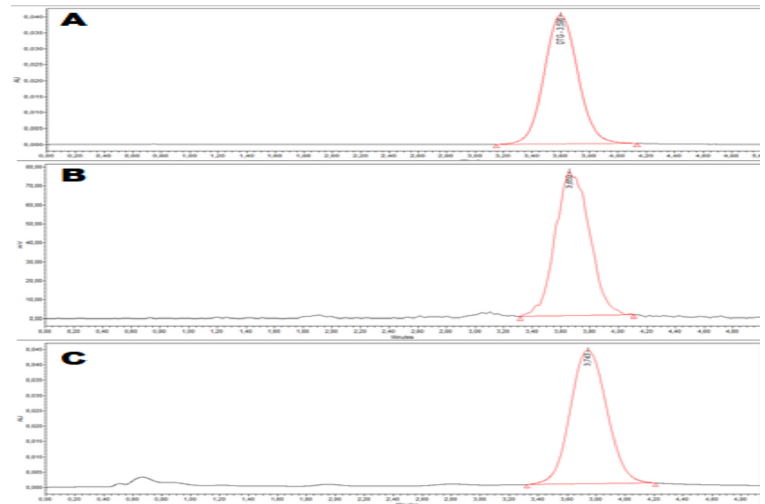
Figure 2. Quality control of [ 18 F]DTG by analytical HPLC. ( A ) UV (258 nm) chromatogram of the reference compound DTG; ( B ) gamma chromatogram of the radiotracer [ 18 F]DTG; ( C ) UV (258 nm) chromatogram of the radiotracer [ 18 F]DTG.